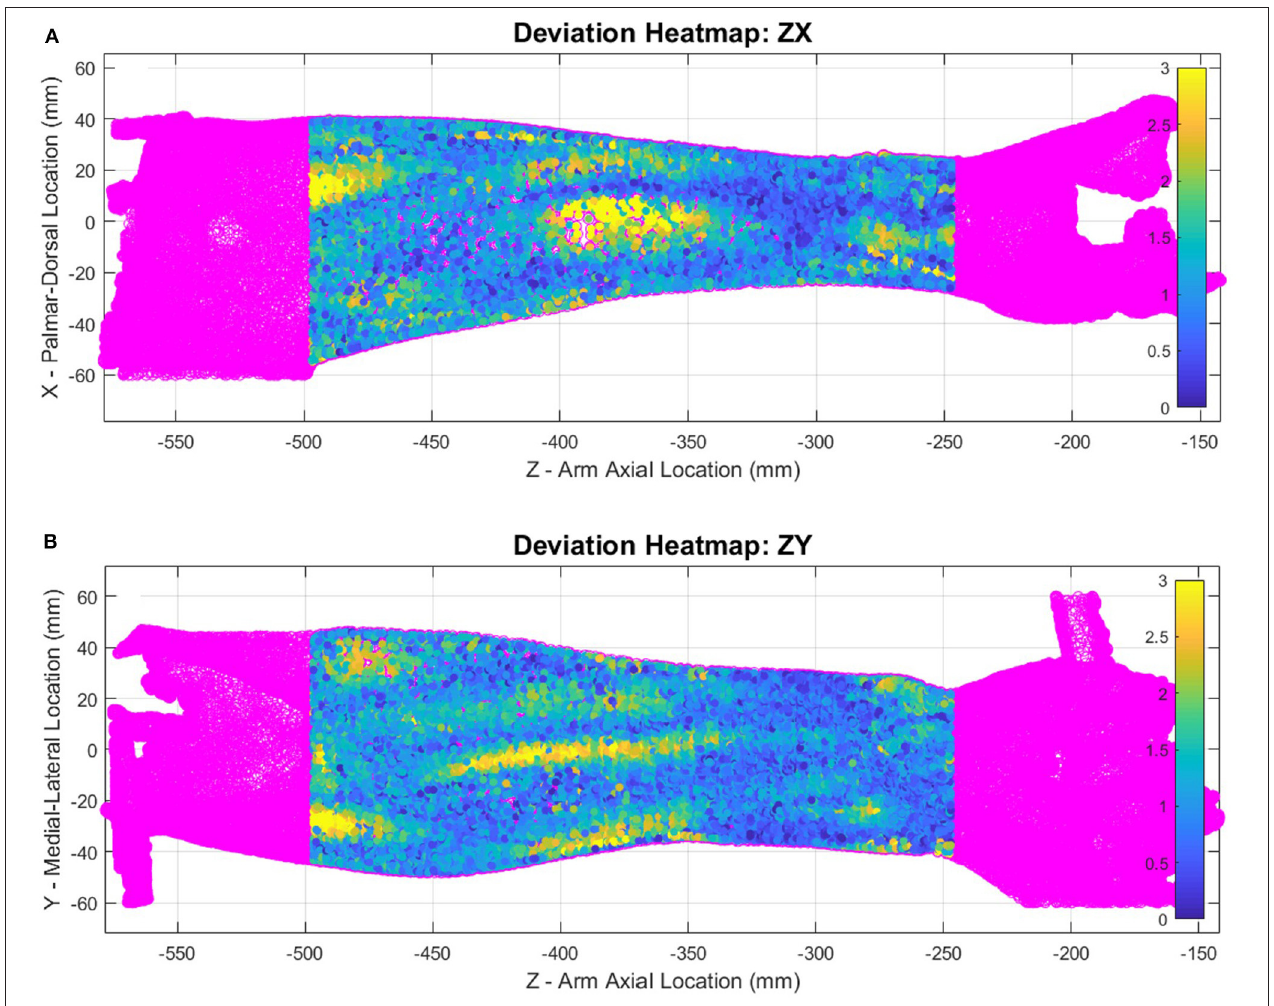
FIGURE 7 | Supination pose heatmap of deviation between scanned data and ellipse-fit model of subject 6, shown in ZX plane (A) and ZY plane (B) . The heat map represents mm of